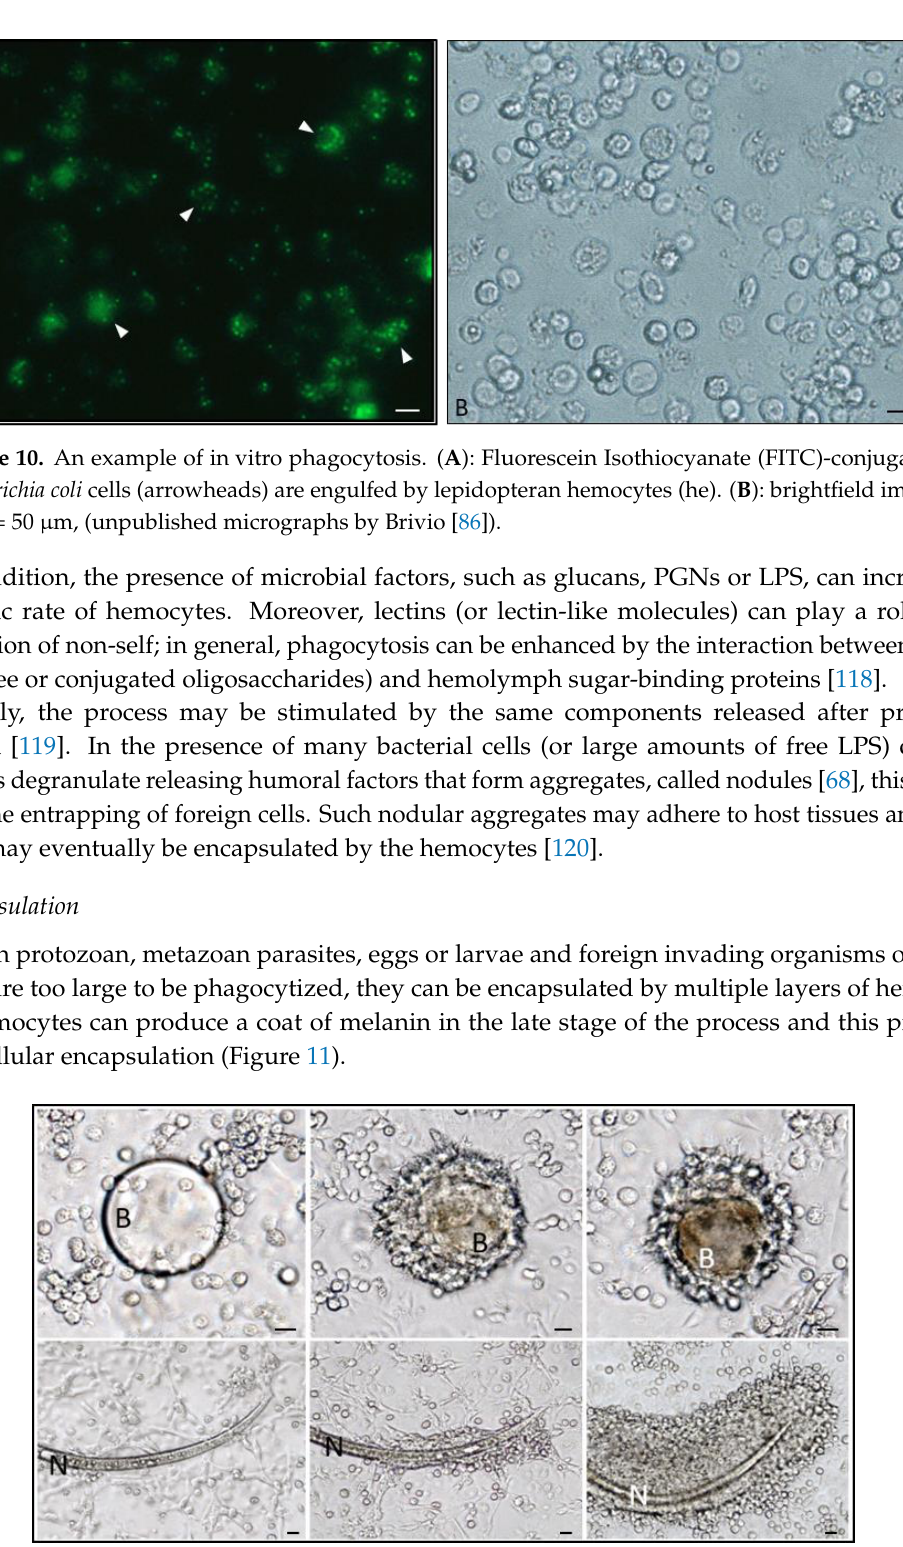
Figure 11. G. mellonella hemocytes forming capsule around abiotic materials and free-living nematodes. ( Upper ) panels show encapsulation steps from 1 to 8 h after incubation of cultured hemocytes with synthetic beads (B); in the right micrograph is evident the melanin deposition around the bead inside the inner cell layer. In ( lower ) panels the same experiment was carried out with free-living nematodes P. rigidus (N). In both assays the progressive formation of multi-layered cellular capsules is observable. Bars = 50 µ m (from [121]).